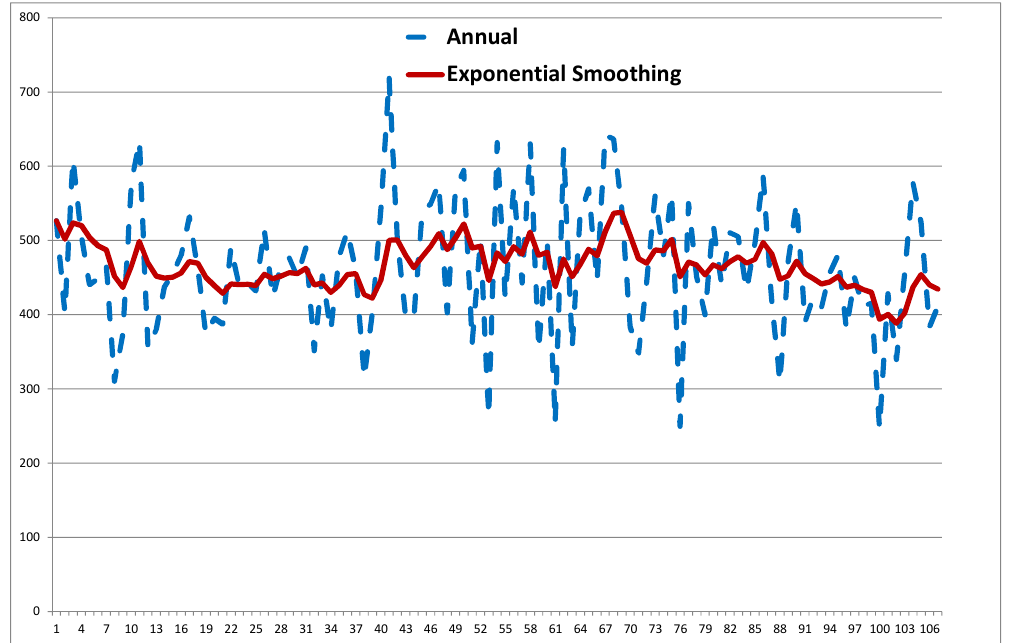
Figure 13. Annual rainfall totals for Keith, 36 . 10 ◦ S, 140 . 36 ◦ E, for